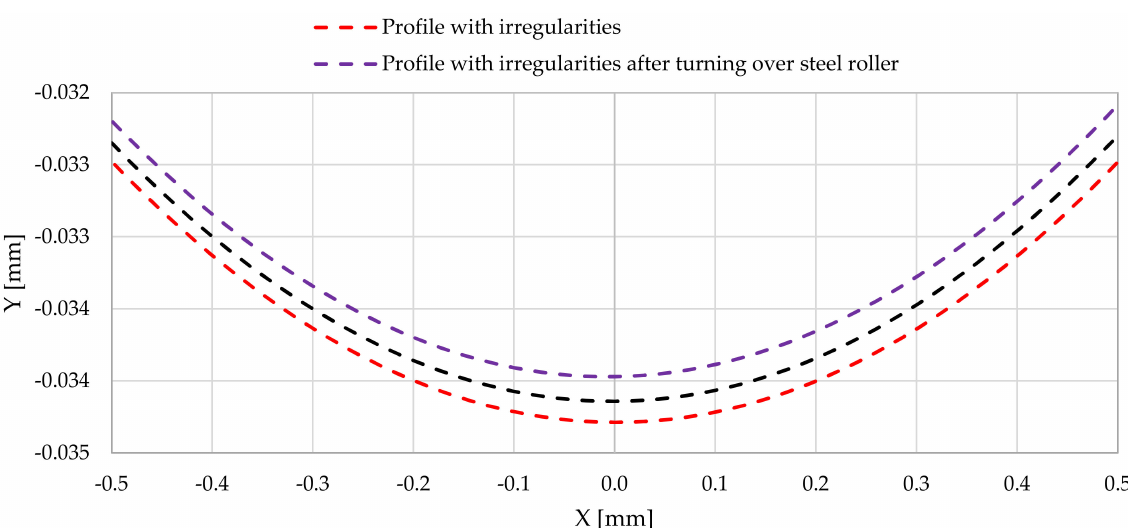
Figure 19. Comparison of the actual profile of a steel shaft with the profiles after the actual outline has been turned over a support roller made of steel and a support roller made of aluminum–bronze.